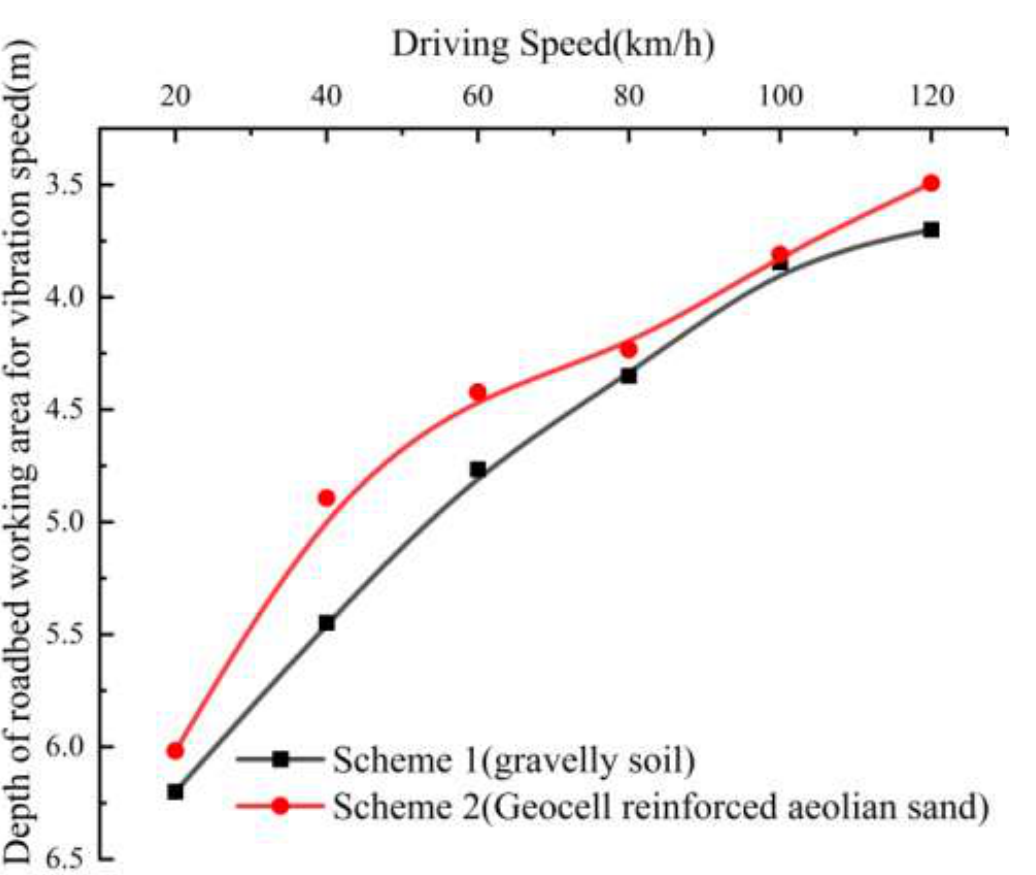
Figure 16. Depth of roadbed working area for vibration velocity.